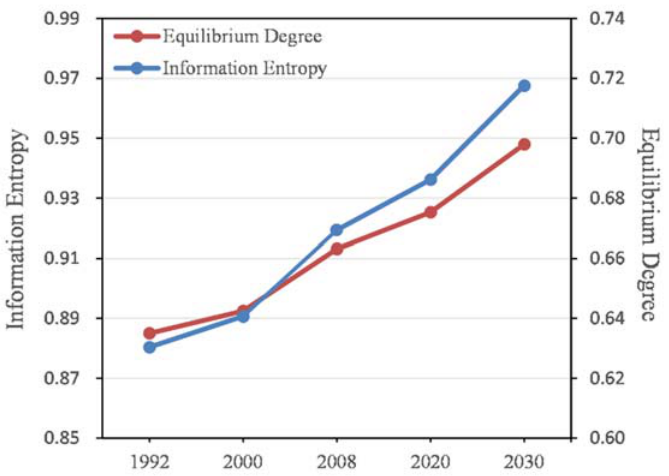
Figure 8. Change of land use information entropy and equilibrium degree.